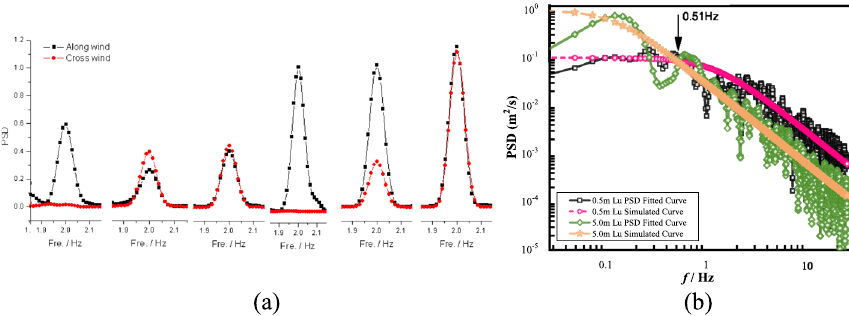
Fig. 10 Ratio of different energy amplitudes of adjustable fluctuating wind obtained from the combined turbulence simulation load conditions (Ma et al., 2013). a Adjustable fluctuating wind. b Different enery